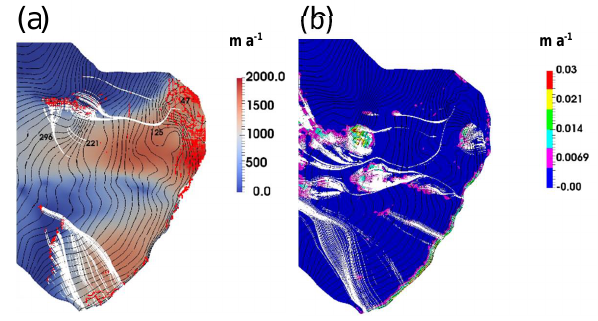
Figure 6. The flow paths of different water sources derived from the results in August 2012. (a) The white lines indicate the path of the surface meltwater after entering the glacier bed via cut-through crevasses (red dots) according to hydraulic potential. The modelled basal velocity magnitude is colour-coded in the background. (b) The white lines indicate the water path of the basal meltwater from loca- tions with in situ melt rates above 0.005ma − 1 . The coloured con- tour lines indicate the value of the basal melt rate. The black contour lines in both (a) and (b) indicate isovalues of the hydraulic potential with a ∼ 10m